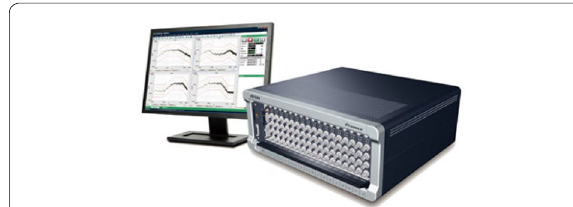
Figure 22 VT series vibration controller